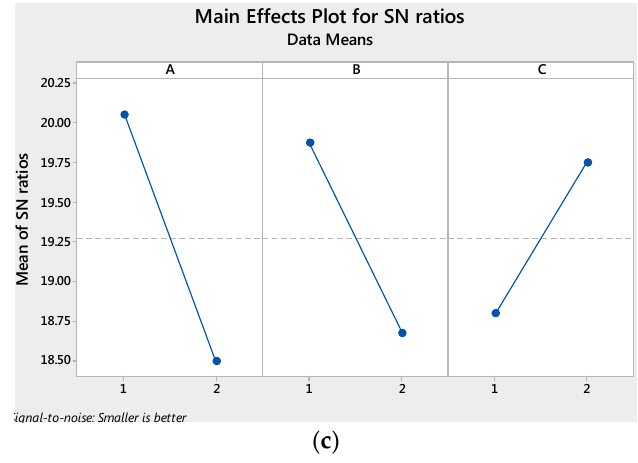
Figure 4. Main effect plots: ( a ) for overcut; ( b ) for taper angle; ( c ) for surface roughness.